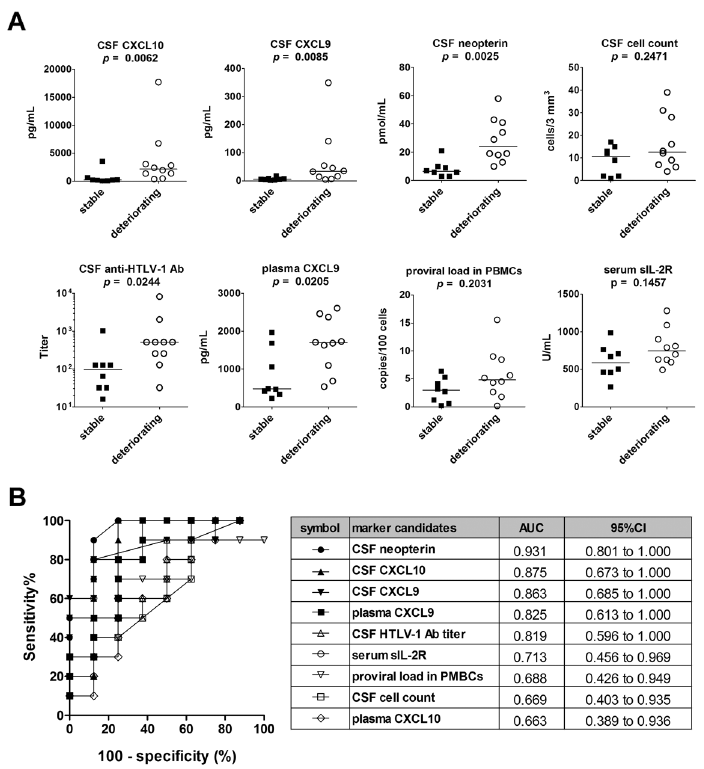
Figure 5. Comparison of potential markers in stable and deteriorating HAM/TSP patients with similar disease durations. ( A ) Five CSF marker candidates (CXCL10, CXCL9, neopterin, cell count, and anti-HTLV-1 antibody titer) and four blood marker candidates (proviral load in PBMCs, serum sIL-2R, plasma CXCL9, and plasma CXCL10) were compared among all patients from both the Training and Test Sets pooled together with similar disease durations (range: 7–13 years; no significant difference in duration between stable (n=8) and deteriorating (n=10) groups). Data is shown for the top eight CSF markers ranked according to the significance of the difference between the deteriorating and stable subjects. Horizontal bars indicate the median values. The Mann-Whitney U -test was used for statistical analysis. ( B ) ROC analysis was employed to assess the sensitivities and specificities of the nine markers listed above for discriminating deteriorating HAM/TSP patients from stable patients while controlling for disease duration. AUC=area under the ROC curve; 95% CI=95% confidence interval.